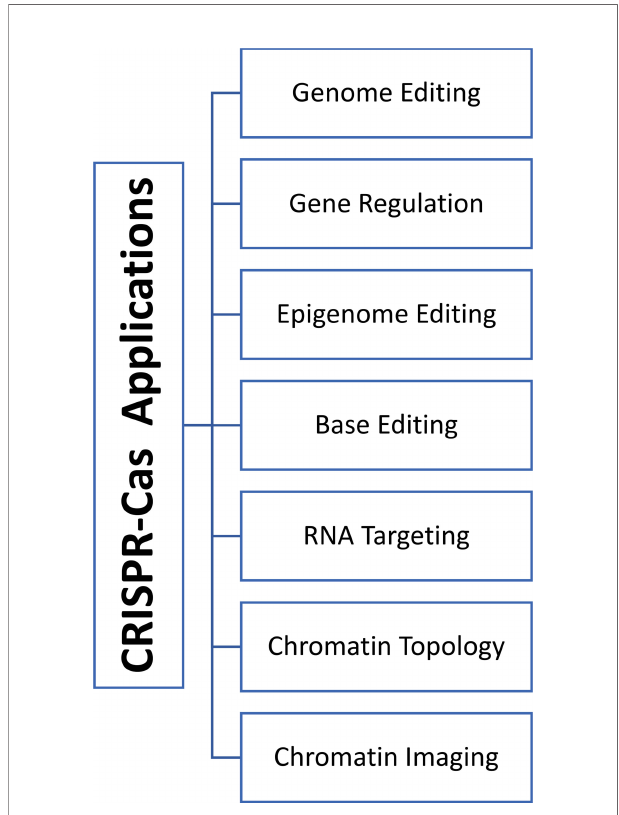
FIGURE 1 | Different areas of applications of CRISPR-Cas